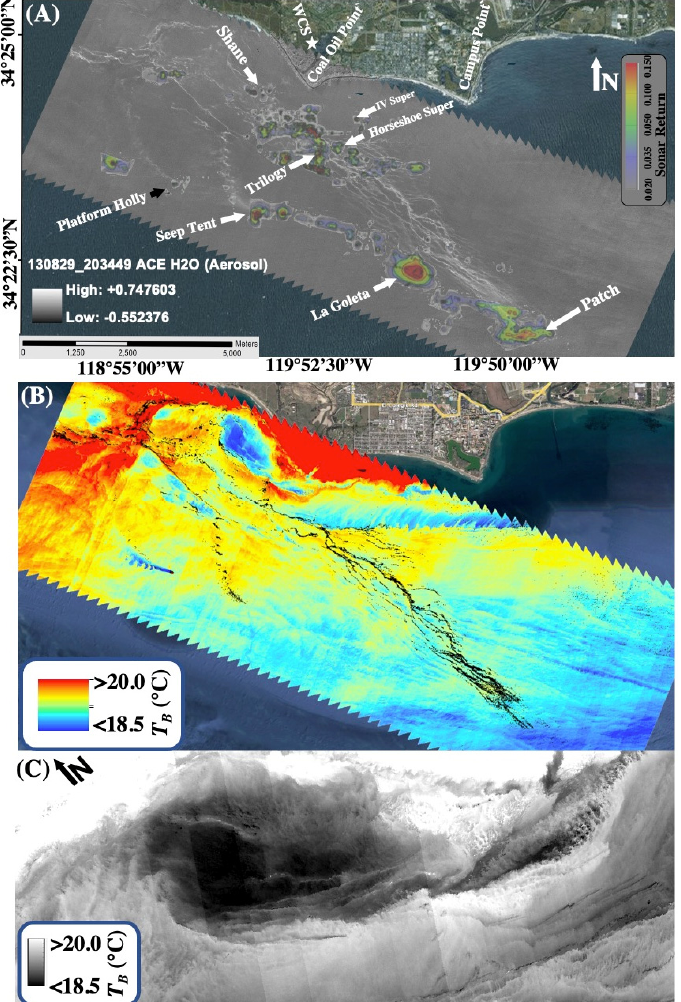
Figure 4. ( A ) ACE filter imagery of the COP seep field and sonar seepage map—adapted from Leifer [14]. Major, informally named seep areas labeled. WCS is West Campus Station, from which wind data were acquired. ( B ) Brightness temperature map and ACE oil detection (black). ( C ) COP gyre detail—see Supplementary Figure S1 for full T B map. Data key on panel ( A ). Imagery acquired 29 August 2013. Panels ( A ) and ( B ) shown in the Google Earth